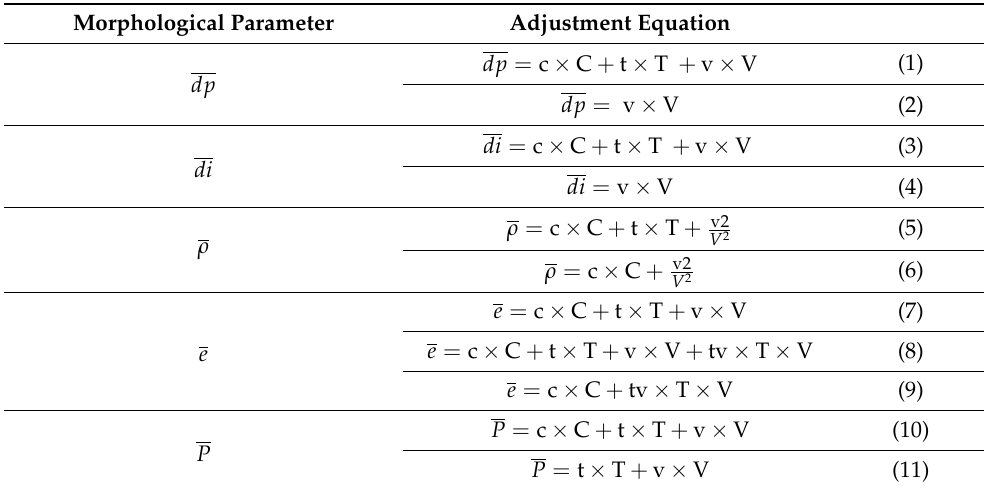
Table 1. Mathematical equations proposed for the adjustment of morphological parameters as a function of the synthesis